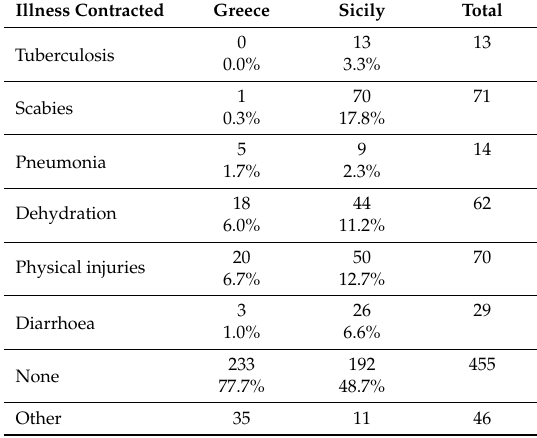
Table 5. During your journey did you contract any of the following health issues...? (per cent within